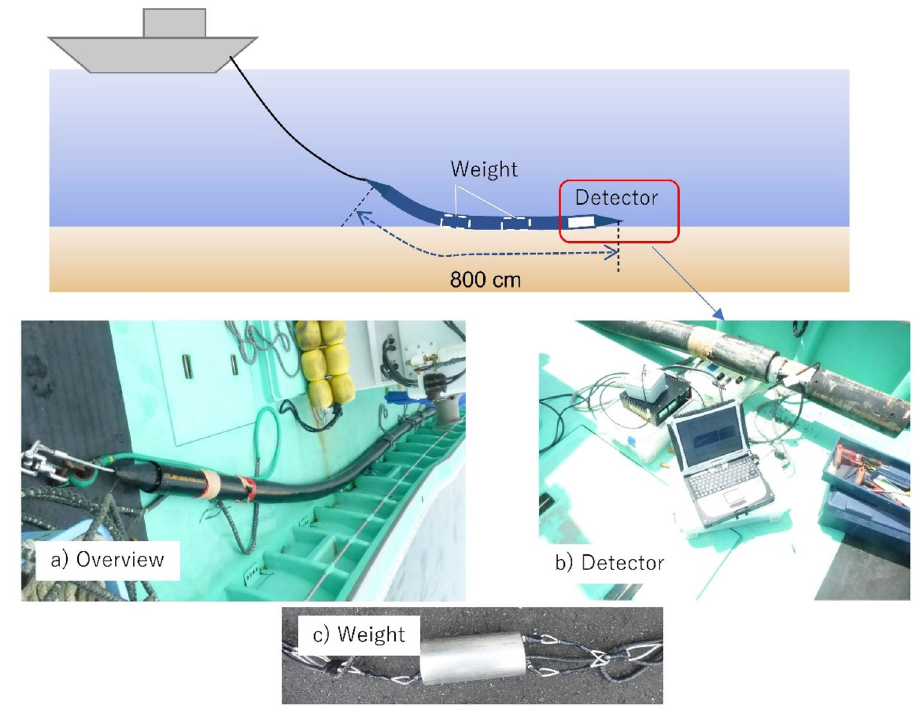
Figure 5. Image of the towed gamma-ray detection